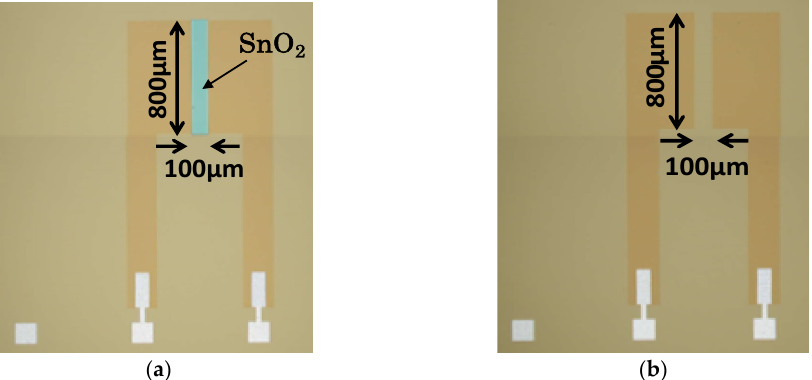
Figure 3. Optical microscope photo of the fabricated FET. ( a ) SnO 2 -gate FET; ( b ) Si 3 N 4 -gate FET.